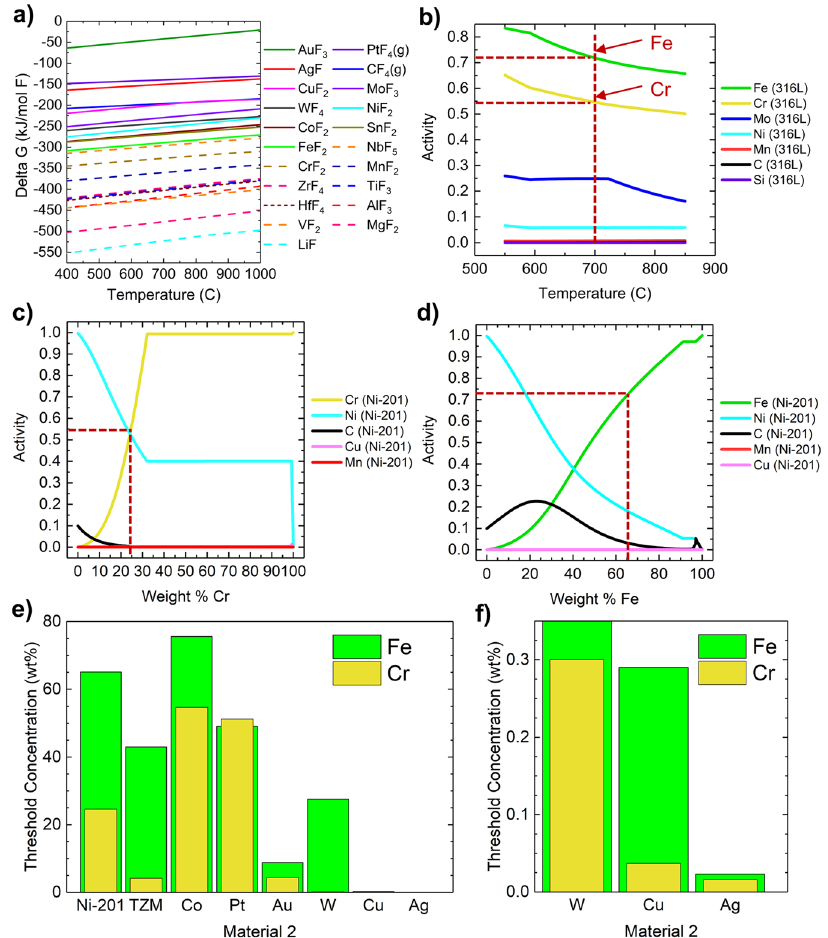
Fig. 1 Results for fl uoride formation energy and activity calculations. a Fluoride formation energies calculated using HSC V.7.00 22 . b Activities of main alloying elements in 316L. c , d Activity of Cr and Fe, respectively, as functions of increasing weight % in Ni-201. e Fe and Cr threshold concentration plots for all second materials. f Zoomed in threshold concentration plot to better show threshold concentrations in W, Cu, and Ag